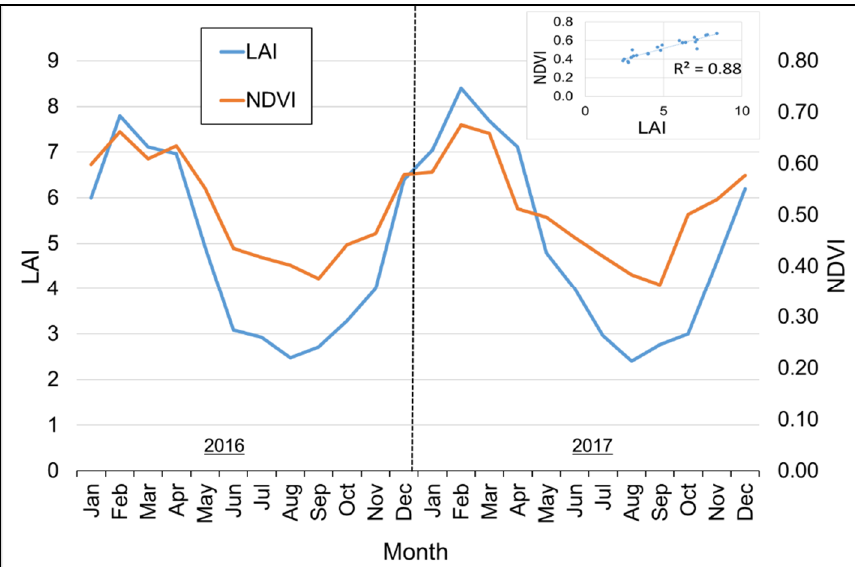
Figure 2. Distribution of monthly NDVI and LAI factor for 2016–2017.